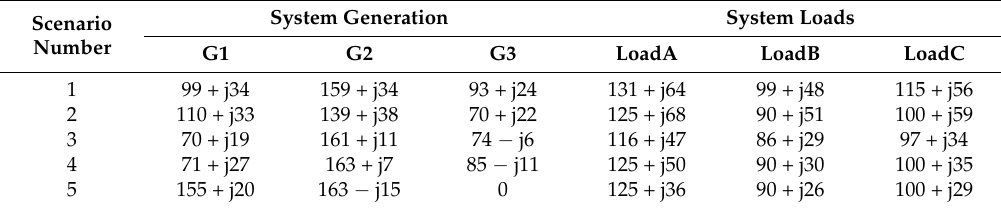
Table 3. Operation scenarios, loads and generation of power system: P(MW) + j Q(Mvar).